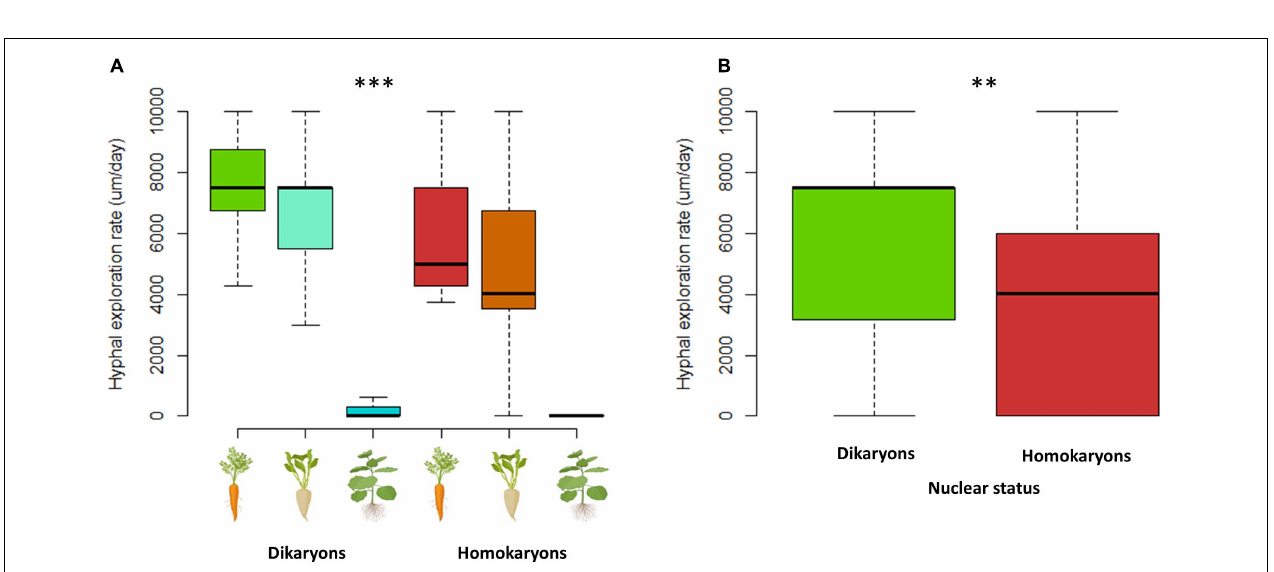
FIGURE 8 | Hyphal network density (A,B) and total number of spores (C,D) variation between dikaryotic and homokaryotic strains of Rhizophagus irregularis per root organ culture host used in the study. (A,C) Trait variation per nuclear status and host plant identity. (B,D) Trait variation per nuclear status. ∗∗ indicates statistical significance at < 0.01 and ∗∗∗ indicates statistical significance at < 0.001.